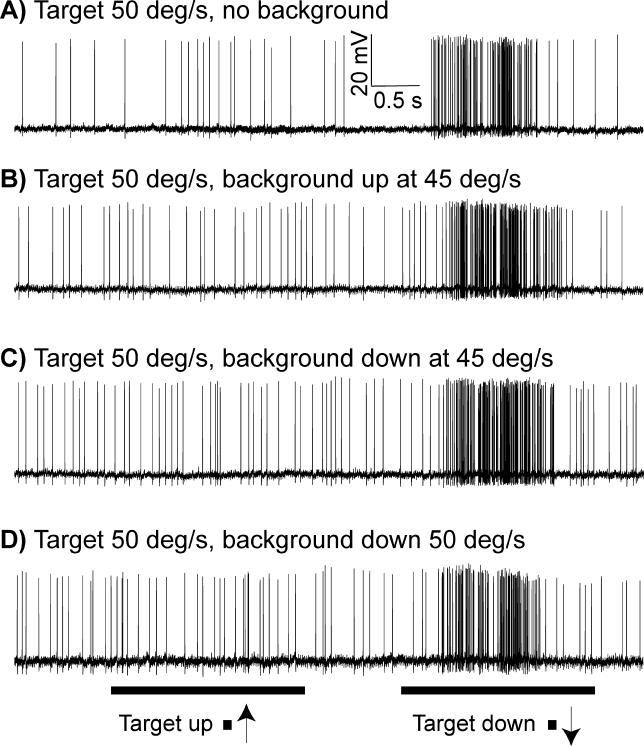
Responses of STMD 2 to Targets Drifted against Cluttered Backgrounds(A) Control experiment showing the sharp response to downward motion of targets (at 50°/s) as they cross the center of the receptive field. Addition of motion of a background texture moving either upwards (B) or downwards (C) at slightly lower speed (45°/s) has little effect on the response. Even when the background is drifted at the same speed (50°/s) and direction as the target (D), the neuron continues to respond.